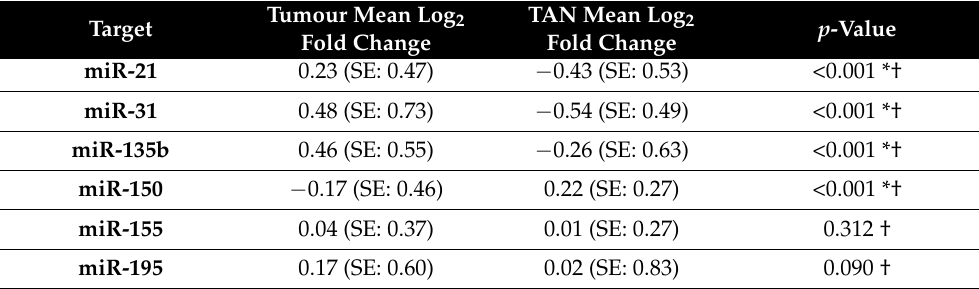
Table 3. Fold change expression of miRNA targets in the combined discovery and validation sets used for discriminating colorectal tumour tissue from tumour-associated normal samples.